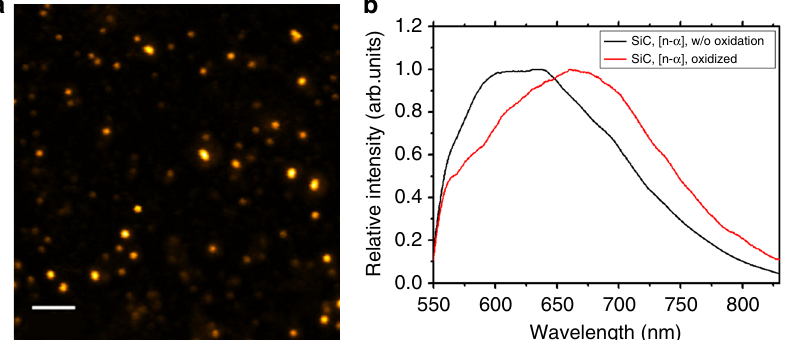
Fig. 4 Spectral characterization of irradiated SiC nanoparticles. a Confocal image of irradiated, annealed and oxidized SiC nanoparticles deposited on a glass cover slip. The scale bar corresponds to 5 μ m. b Photoluminescence spectrum of only irradiated (w/o oxidation) and of irradiated, oxidized and annealed (oxidized) SiC nanoparticles. The band around 670 nm was assigned to the carbon antisite-vacancy pair 70